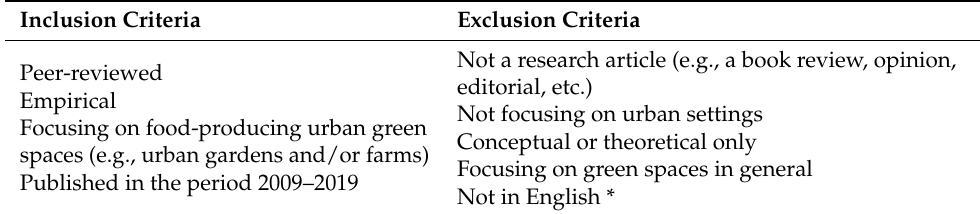
Table 1. Inclusion and exclusion